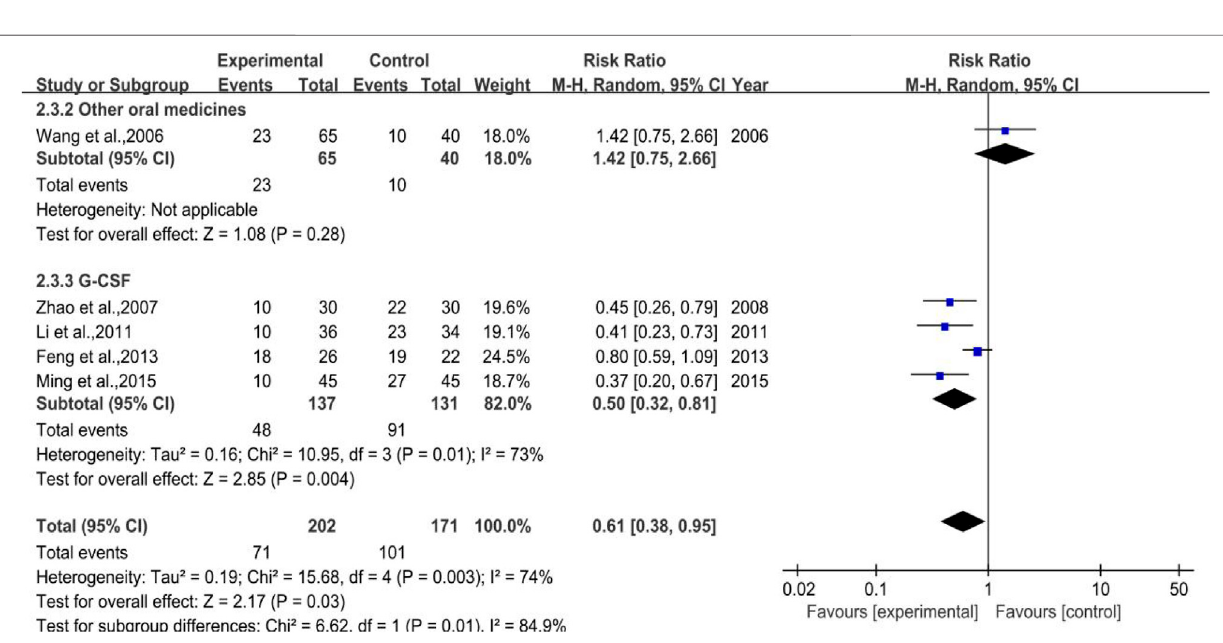
FIGURE 14 | The forest plot of white blood cell suppression rate in therapeutic medication.